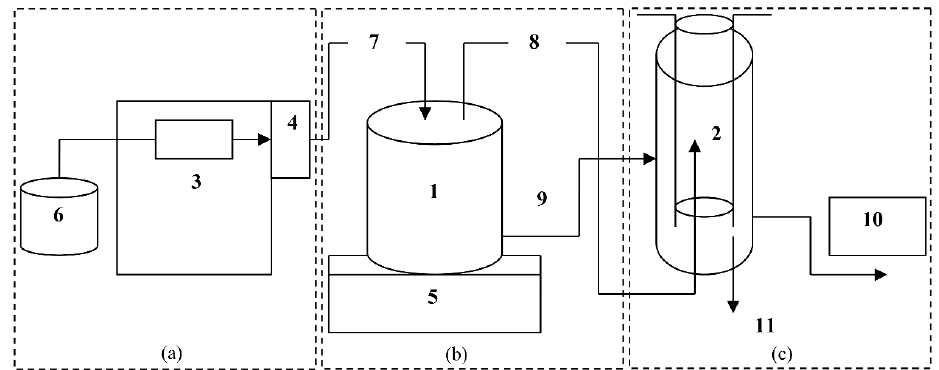
Figure 1. Schematic diagram of a continuous anaerobic digestion pilot plant.